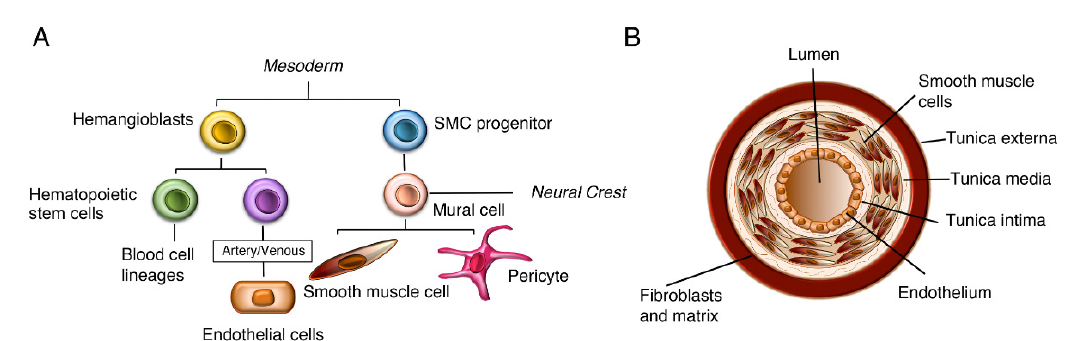
Figure 3. Lineage and role of vascular smooth muscle cells. ( A ) Lineage of vascular smooth muscle cells (VSMCs) showing relationship between different cell types that comprise the blood vessels. VSMCs are derived from both mesodermal and neural crest origins. ( B ) Schematic view of cross- section of an artery indicating layered structure of the vessel wall.